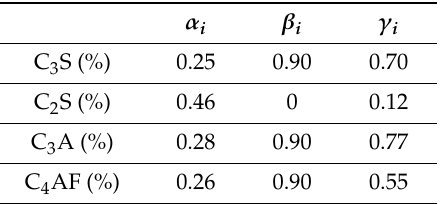
Table 2. Constants of compounds in cement